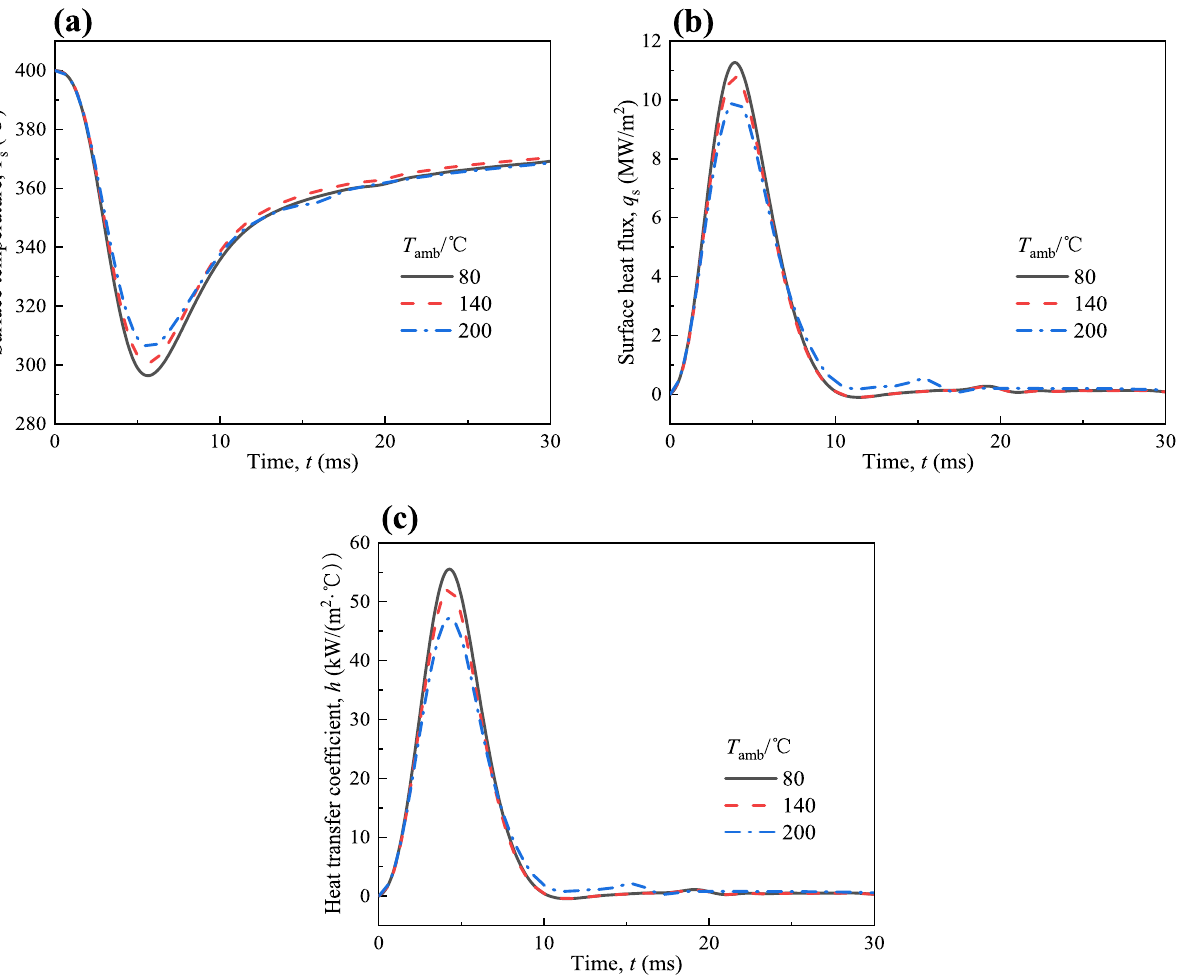
Figure 6. Variations of ( a ) T s , ( b ) q s and ( c ) h at different T amb with spray-wall impingement for T init = 400 °C and P inj = 160 MPa.